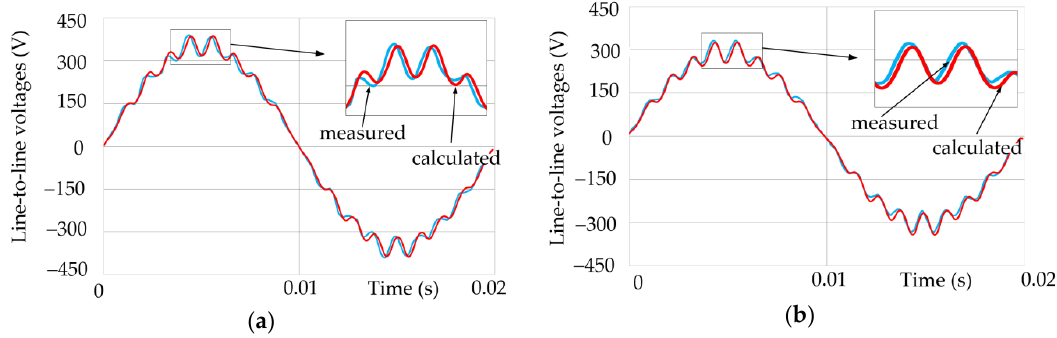
Figure 4. Test stand: ( a ) measuring apparatus, ( b ) BEMF (back electromotive force) test stand where